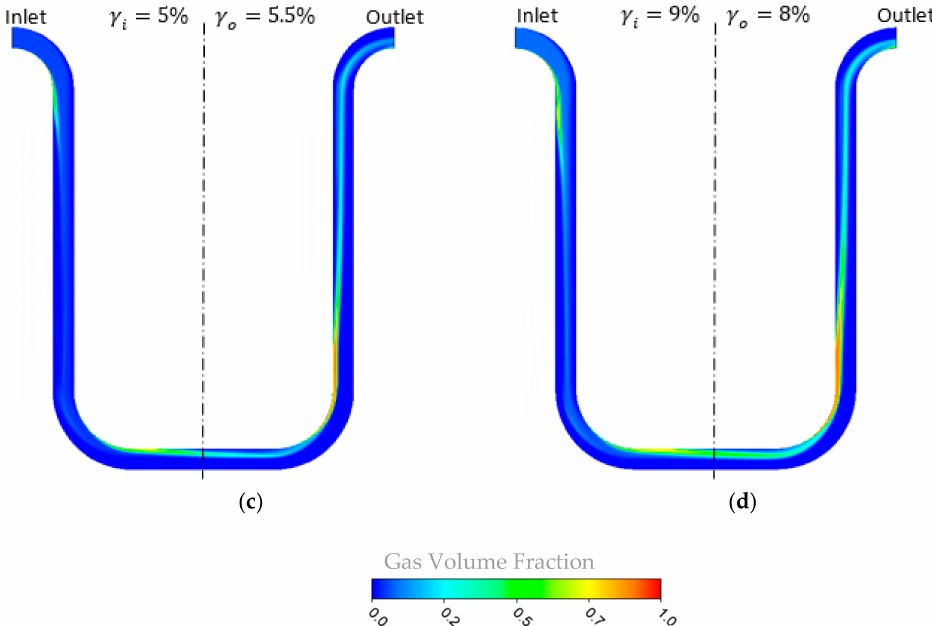
Figure 13. The gas distribution in flowmeter tube at different flow conditions obtained by numerical simulation at bubbly regimes. ( a ) 182 kg/min mixture flow rate, 12% GVF at the inlet, − 4% gas asymmetry ( γ d ) , D300. ( b ) 182 kg/min mixture flow rate, 8% GVF at the inlet, − 3% gas asymmetry ) , D300. ( c ) 300 kg/min mixture flow rate, 5% GVF at the inlet, − 0.5% gas asymmetry ( γ ( γ d CMF200. ( d ) 300 kg/min mixture flow rate, 8% GVF at the inlet, 1% gas asymmetry ( γ d ) ,